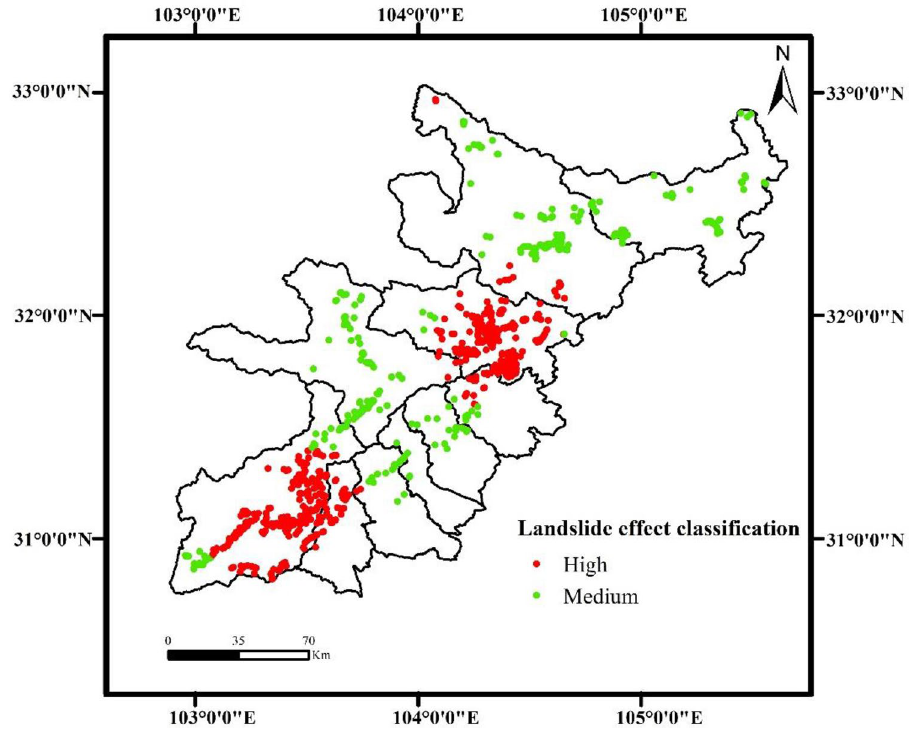
Figure 5. Calculation results of the spatial characteristics of landslides (Name of software: ArcGIS